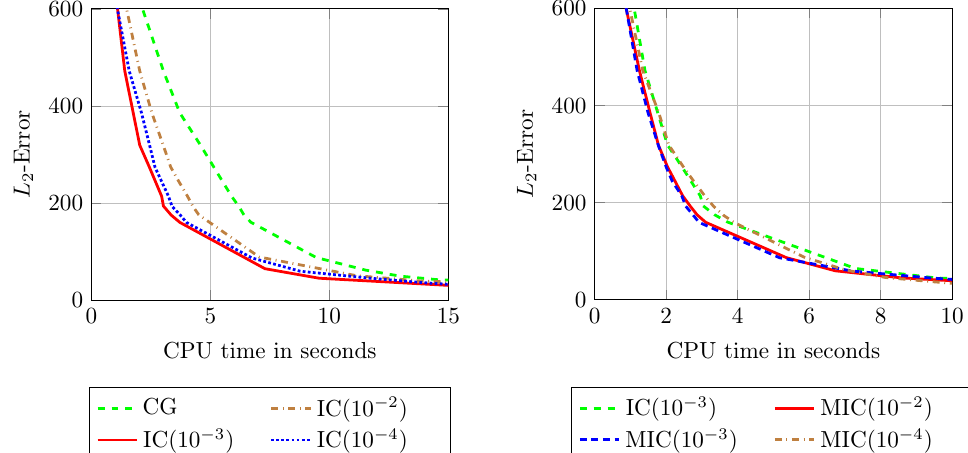
Figure 6. Results of the two-dimensional GES experiment without source: comparison of the L 2 -error and the corresponding CPU time using iterative CN at t F = 2.609 10 6 for h = 0.04. The stopping × criterion is fixed to ε = 10 − 4 . The reference solution is computed with the EE method. Left: Iterative CN is computed using IC-preconditioner for different drop tolerances γ . The choice γ = 10 − 3 provides the best trade-off. Right: Iterative CN is computed by IC(10 − 3 ) and MIC-preconditioner for [ 10 − 3 ,10 − 2 ] is optimal. different drop tolerances γ . A value for γ ∈ Results on KSMOR